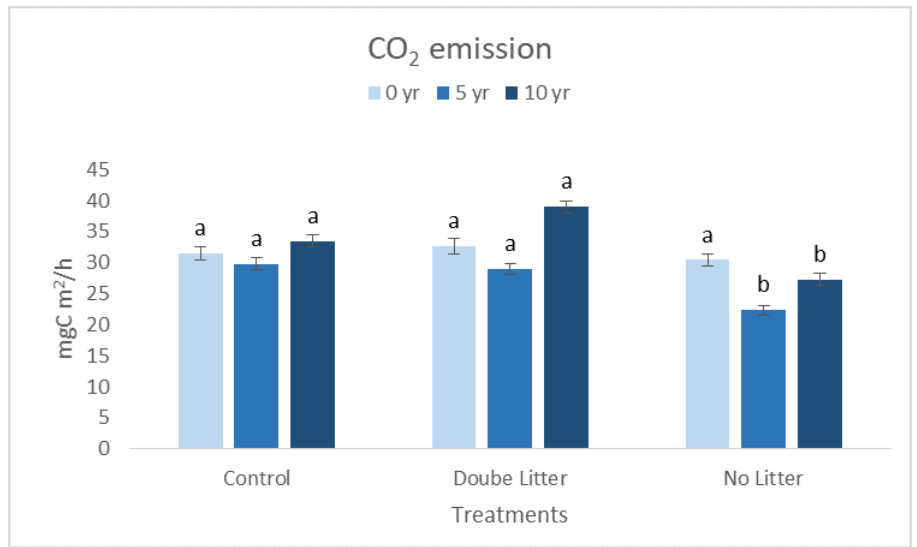
Figure 4. Carbon dioxide emissions from the soil at the start of the treatments and after 5 and 10 years, based on spring measurements (Average of 6 samples per treatment; Letters indicate the significant difference between treatments within the same sampling time.).